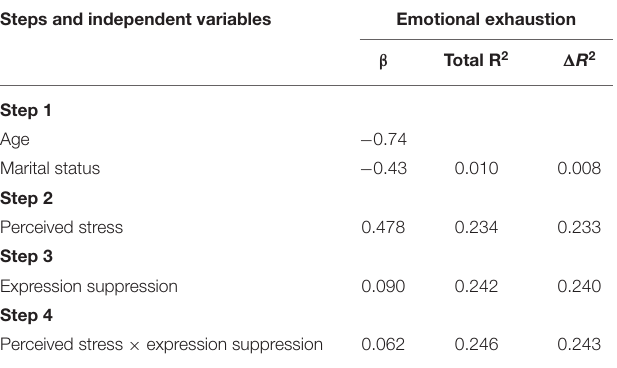
TABLE 3 | Hierarchical multiple regression analyses of perceived stress and expression suppression on emotional exhaustion ( n = 1,372). Steps and independent variables